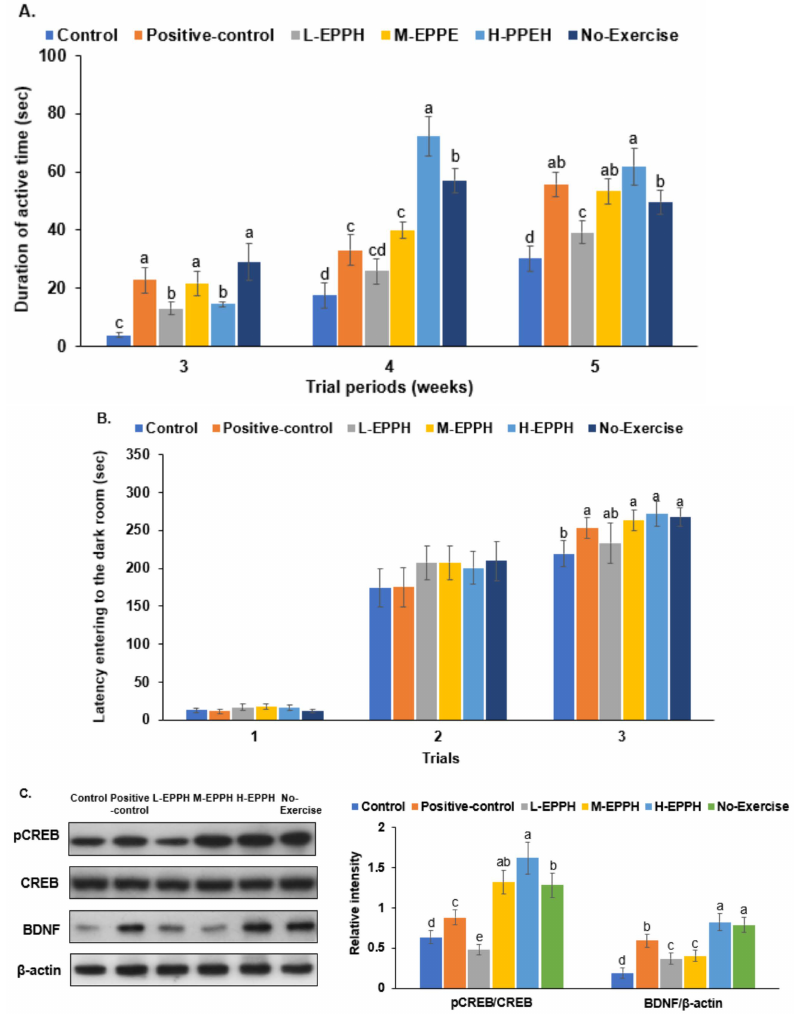
Figure 4. Brain fatigue; ( A ) the active time during forced swimming; ( B ) latency entering the dark room; ( C ) hippocampal Western blots. Bars and error bars represent means ± standard deviation (SD; n = 10). The rats with exercise-induced fatigue had oral administration of distilled water for the control group, porcine placenta enzyme hydrolysates (EPPH) dissolved in distilled water for experimental groups, and glutathione (100 mg/kg body weight) for the positive-control group. EPPH (0.08, 0.16, and 0.32 mL/kg body weight) was orally provided with a feeding needle for the L-EPPH, M-EPPH, and H-EPPH groups, respectively, for 6 weeks. The rats that had no exercise-induced fatigue and oral administration of distilled water were designated the no-exercise group. a,b,c,d Different letters on the bars indicate significant differences among the groups by Tukey test at p <